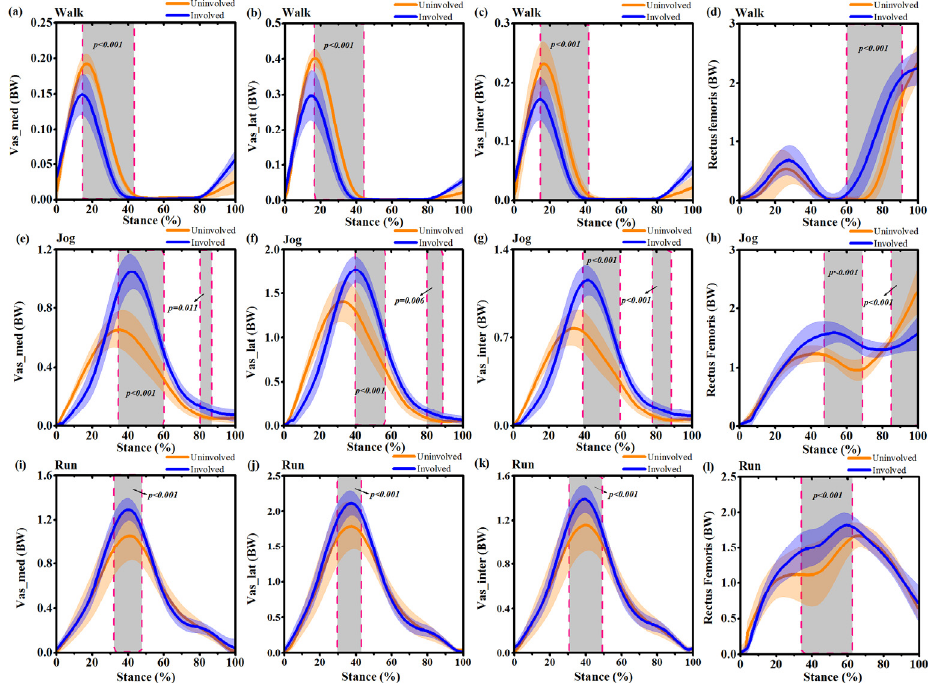
Figure 6. Mean and standard deviation of estimated vas_med (vastus medialis), vas_lat (vastus lateralis), vas_inter (vastus intermedius) and rectus femoris muscle-tendon forces waveforms over stance between the uninvolved side (yellow) and involved side (blue) during walking, jogging and running. ( a ): vas_med muscle-tendon forces during stance phase of walking; ( b ): vas_lat muscle-tendon forces during stance phase of walking; ( c ) vas_inter muscle-tendon force during stance phase of walking; ( d ) rectus femoris muscle-tendon force during stance phase of walking; ( e ): vas_med muscle-tendon forces during stance phase of jogging; ( f ): vas_lat muscle-tendon forces during stance phase of jogging; ( g ) vas_inter muscle-tendon force during stance phase of jogging; ( h ) rectus femoris muscle-tendon force during stance phase of jogging; ( i ): vas_med muscle-tendon forces during stance phase of running; ( j ): vas_lat muscle-tendon forces during stance phase of running; ( k ) vas_inter muscle-tendon force during stance phase of running; ( l ) rectus femoris muscle-tendon force during stance phase of running. Grey shaded regions on graphs indicate a significant di ff erence between the two sides ( p < 0.05) from SPM1d analyses.